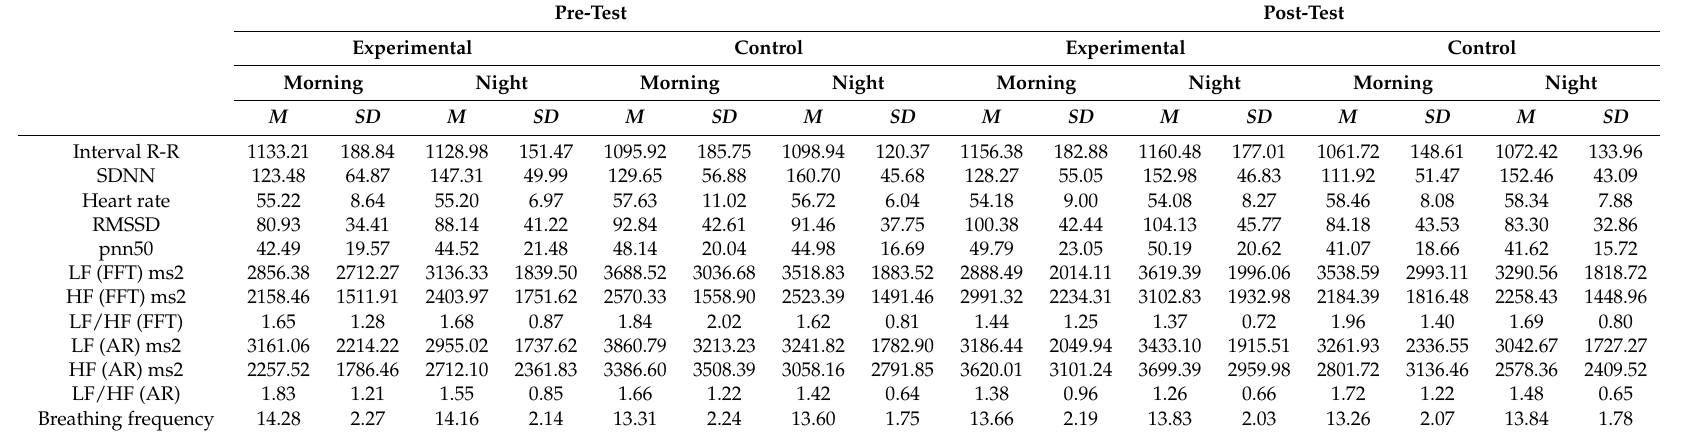
Table 2. Descriptive statistics for heart rate variability